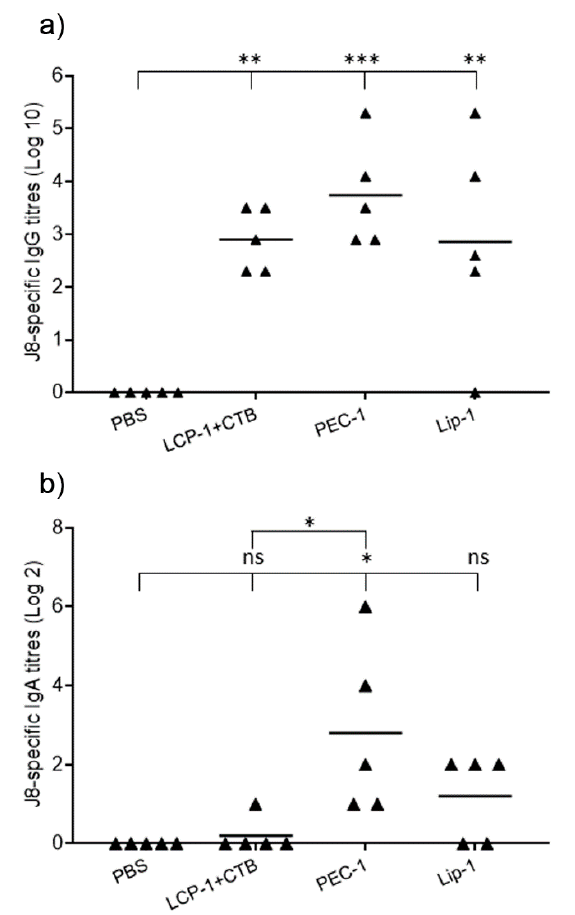
Figure 3. J8-specific serum IgG ( a ) and salivary IgA ( b ) titers in outbred Swiss mice models after second boost (experiment 1). ns, p > 0.05; * p < 0.05; ** p < 0.01; *** p < 0.001; **** p < 0.0001. PBS: phosphate buffer solution, CTB: cholera toxin B.